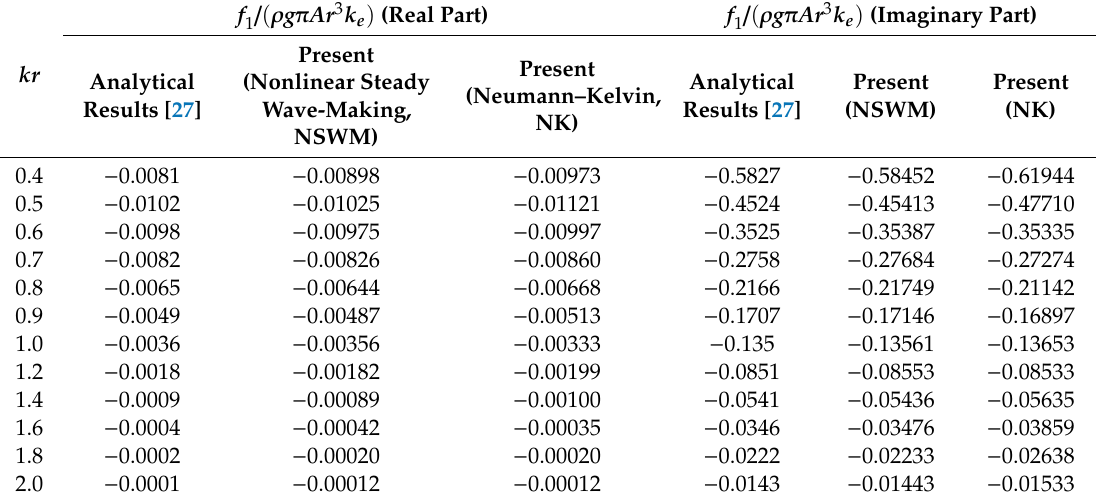
Table 1. Surge wave exciting forces on the sphere ( Fr = 0.4, h = 2.0 r , kcr = 0.26808).